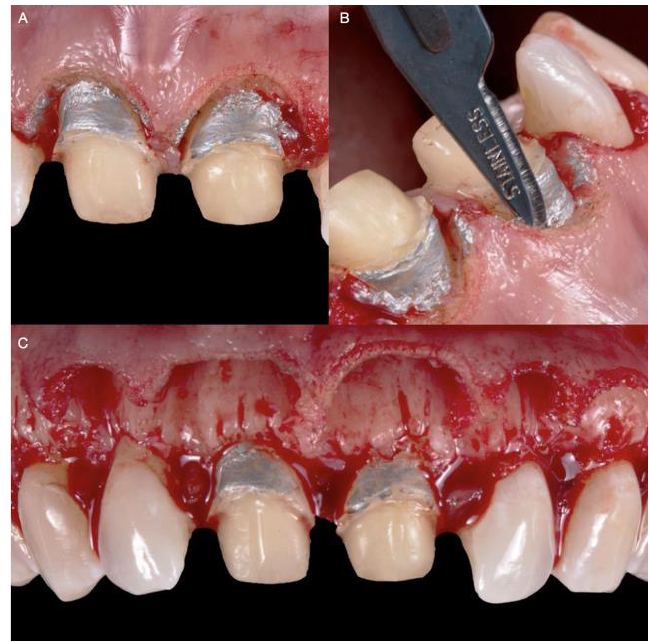
Figure 5. Crown-lengthening procedure: ( A ) Gingivectomy completed; ( B ) Initiation of flap; (C) Flap reflation.